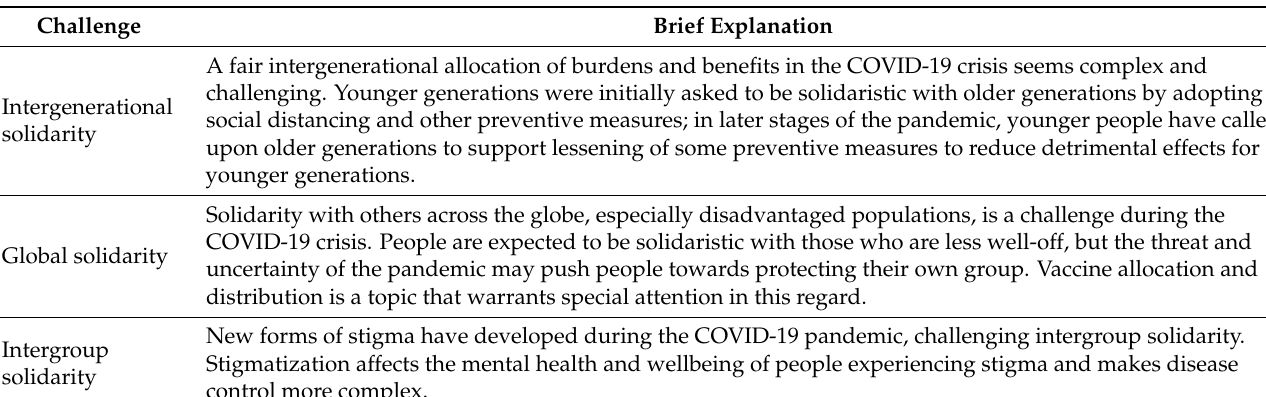
Table 3): how to balance upward and downward solidarity between generations, global solidarity across high-versus-low and middle-income countries (LIMC), and intergroup solidarity between persons with and without an Asian appearance, and the potential stigma attached to having an Asian appearance. Table 3. Schematic overview of challenges to solidarity arising from the COVID-19 pandemic. Challenge Brief Explanation Intergenerational